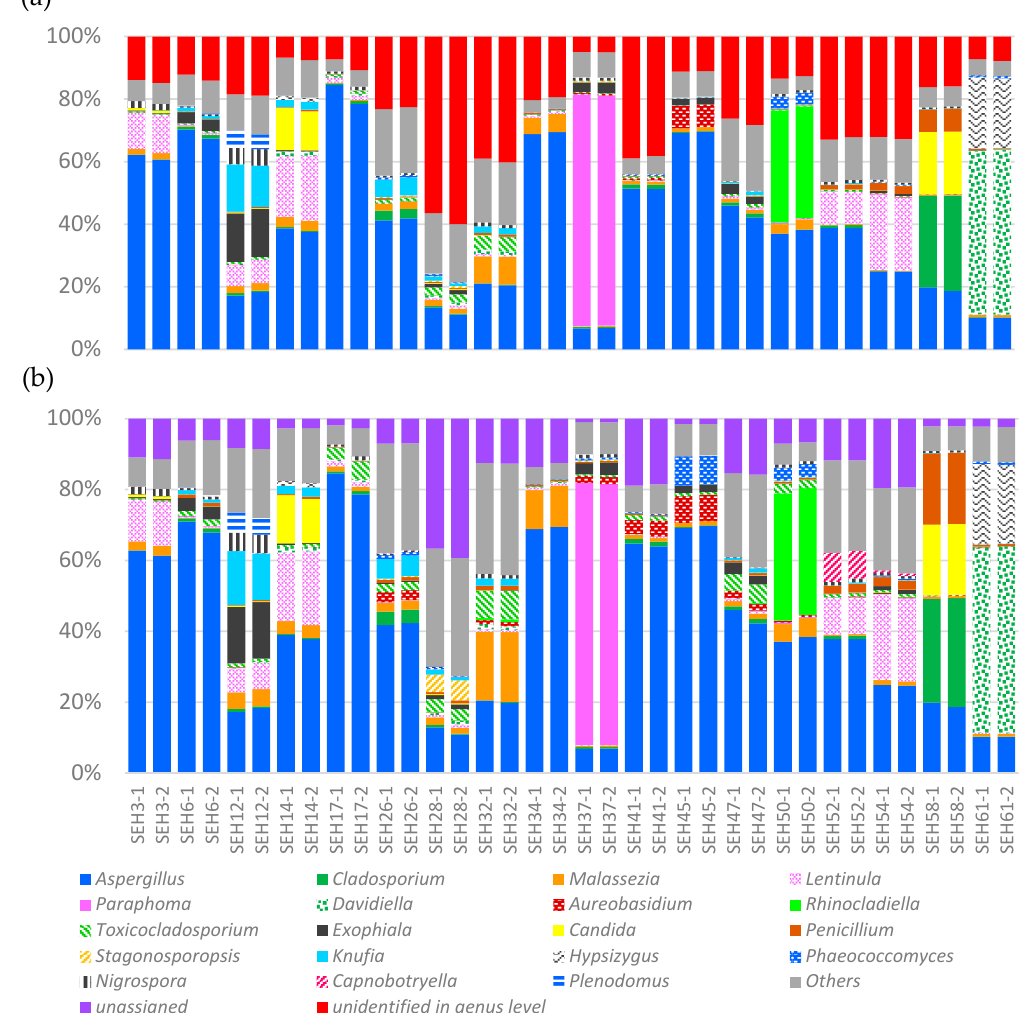
Figure 3. Taxonomic compositions of the fungal communities in 36 PCR duplicates of house dust samples. ( a ) Without the removal of database sequences classified at the genus level; ( b ) with those sequences removed. Gray bar indicates the ‘Others’ category defined as the occupancy rate of the total remaining species other than the 19 genera shown in this figure. Red bar indicates the ‘unidentified at the genus-level category’ defined as the assignment to database registrations that are not classified at the genus level. Purple bar indicates the ‘unassigned’ category defined as the failure to be assigned to any database sequences with more than a 98% homology.